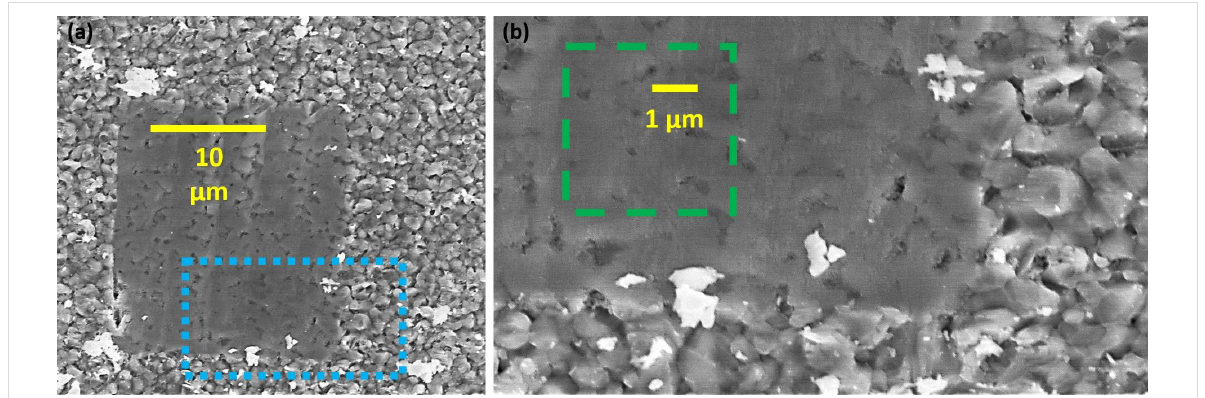
Figure 3: (a) SEM micrograph of a locally planarized polycrystalline CdTe solar cell. The dotted rectangular overlay indicates the location of a higher- magnification SEM image (b) in which the dashed square outline identifies the area studied for Figure 2 and Figure 4.